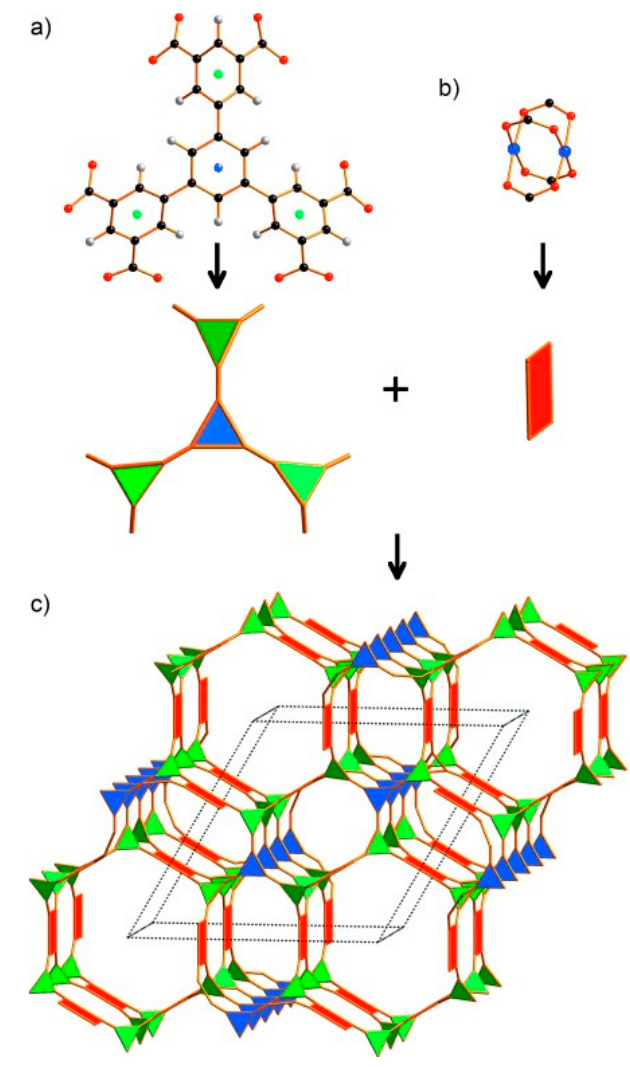
Figure 6. ( a , b ) Organic and inorganic SBUs used to build the zyg net of UTSA-20. Carbon atoms are represented in black, oxygen atoms are represented in red, and copper atoms are represented in blue. Geometric shapes are made based on the underlying net to aid in the representation of the structure of this MOF. ( c ) Coordination figure of UTSA-20 which gives insights into how the secondary building units (SBUs) and geometric shapes are assembled to create this topology. Adapted with permission from Ref. [64]. Copyright 2011 John Wiley and Sons.